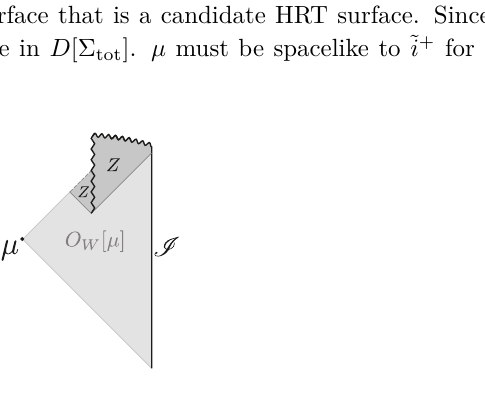
Figure 9 . Example of a Cauchy extension Z of the outer wedge that is spacelike to µ . The fine- grained spacetime M will induce a particular choice of Z . It is possible to choose the coarse grained spacetime so that O W [ µ ] ∪ Z ⊂ M [ µ ]